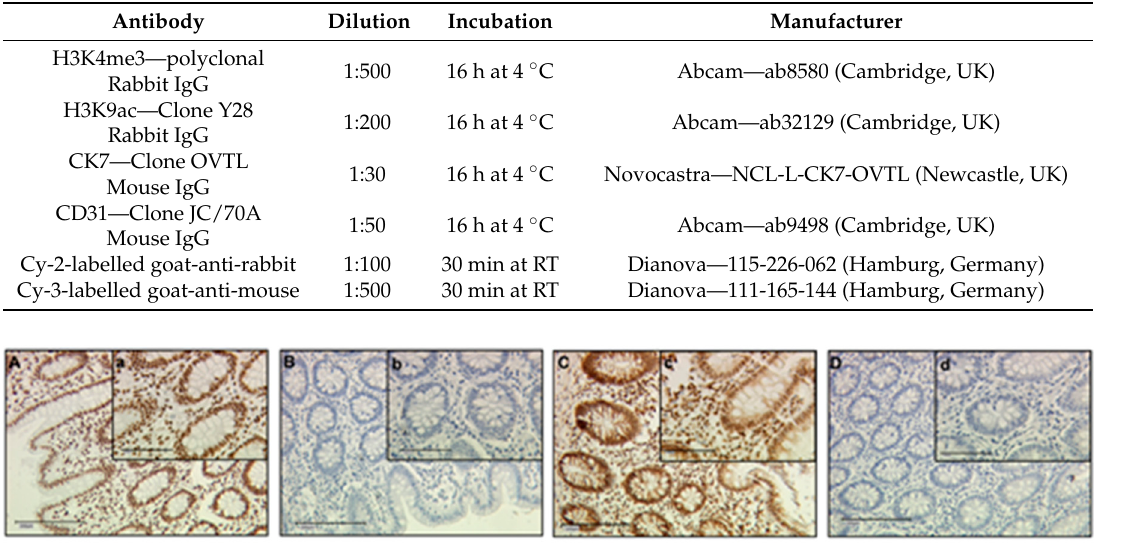
Table 2. Antibodies applied for immunohistochemistry and double-immunofluorescence.